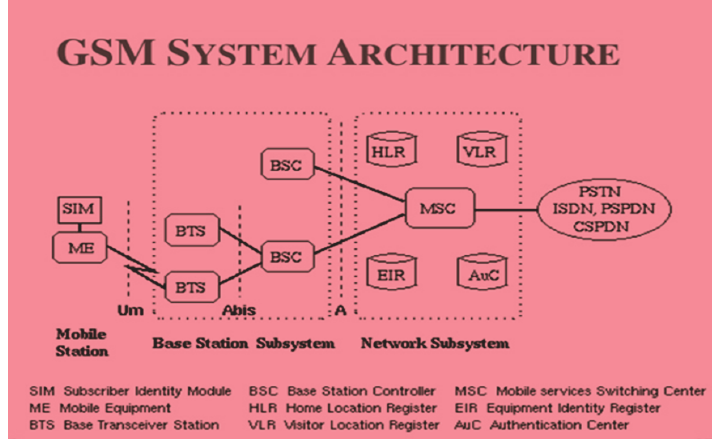
Fig. 3. GSM Architecture (Kurose,